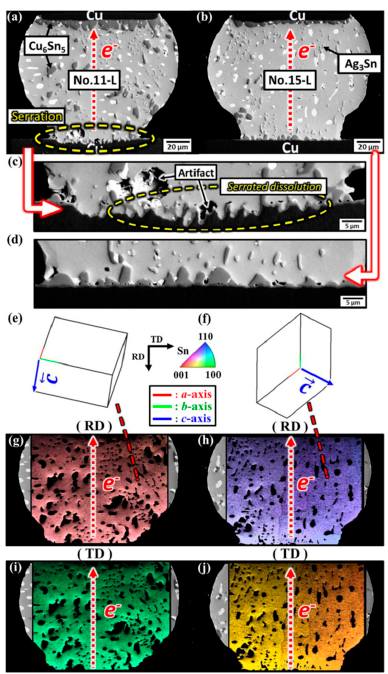
Figure 3. ( a , b ) Cross-sectional micrographs of the solder joints after current stressing of 4.5 × 10 4 A/cm 2 at 50 °C for 1862 h. ( c , d ) Zoomed-in images of the cathode interface of ( a , b ), respectively. ( e , f ) Sn grain orientation for the joint in ( a , b ), respectively. ( g , h ) EBSD analysis map of Sn grain (image quality + inverse pole figure) with rolling direction (RD) for the joint in ( a , b ), respectively. ( i , j ) With transverse direction (TD) Reprinted with permission from Ref. [45] Copyright 2014